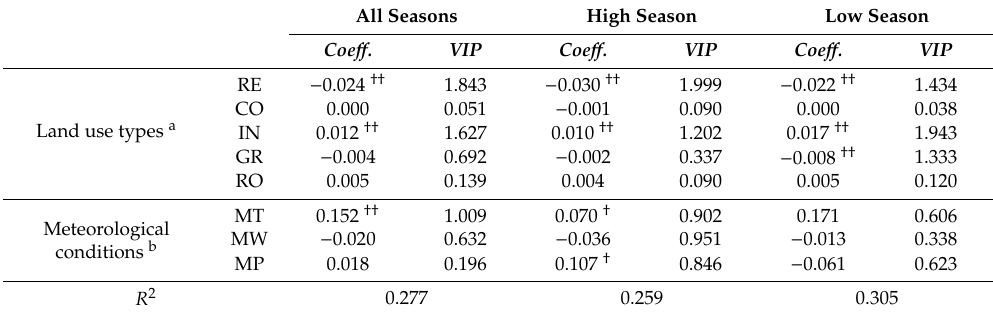
Table 3. Estimation of PM 10 levels based on land use classification I using partial least-squares (PLS) regression models.